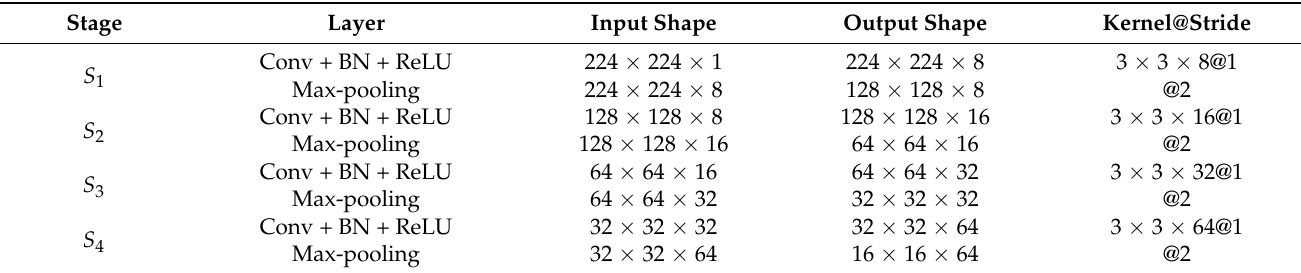
Table 1. Encoder Structure in